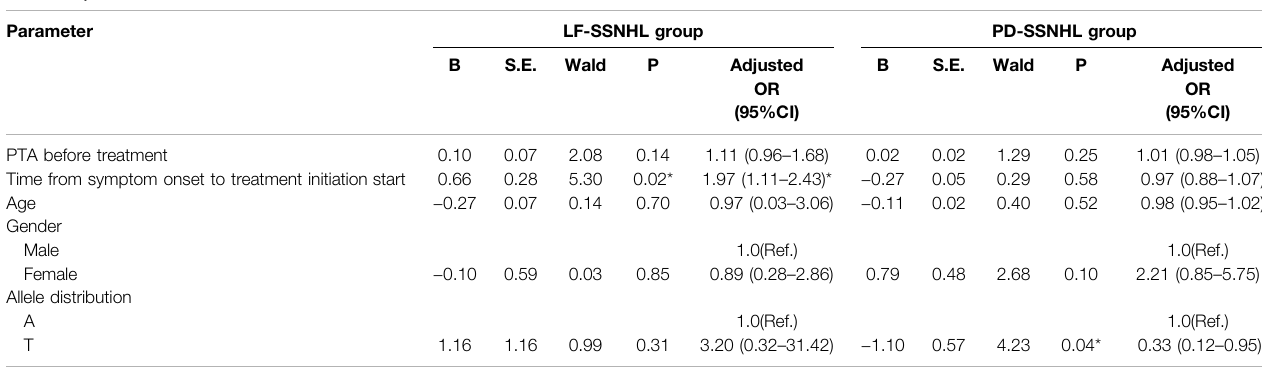
TABLE 3 | Treatment outcome.